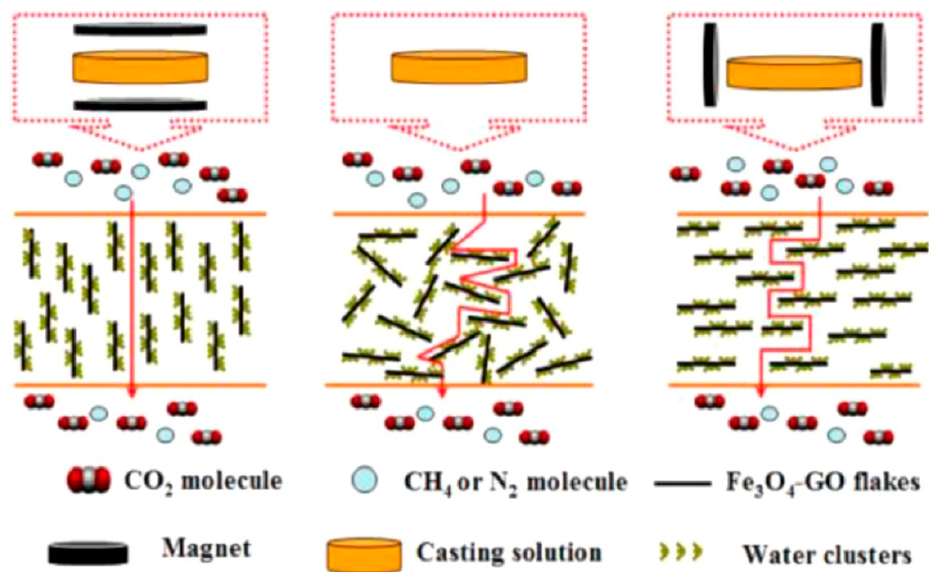
Figure 5. Scheme of MMMs containing flakes with different orientations (from ref. [55]).